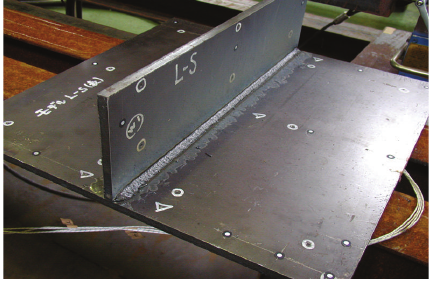
Figure 4: Experimental procedure.